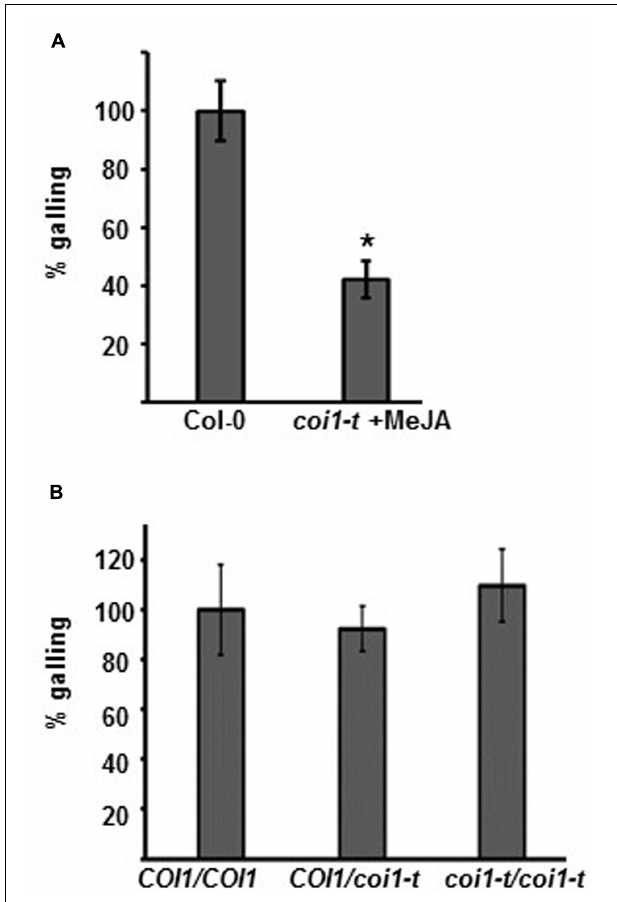
FIGURE 3 | Plant susceptibility to Meloidogyne hapla is COI1-independent. (A) Col-0 seedlings, grown on MS without selection, and coi1-t seedlings, selected on MS + 50 µ M MeJA media, were transferred to fresh MS plates and inoculated with 100 M. hapla J2 per plant. Galls per plant were counted at 14 dpi., and the galling in Col-0 was set to 100%. Bars represent mean values ( ± SE) from the combined results of three independent experiments (Col-0 n = 149, coi1-t n = 148). Asterisk indicates a significant different between mock and treatment group (Welch t -test ∗ p < 0.05). (B) Ten-day-old seedlings on MS media were inoculated with 100 M. hapla J2 per plant. The severity of the infection was determined by counting galls at 14 dpi. The genotype of each plant was then determined by PCR ( COI1/COI1, COI1/coi1, and coi1/coi1 ). The average galling in COI1/COI1 (wild type) was set to 100%. Values represent the means ± SE from three independent experiments. ( n = 35, 75, and 32,